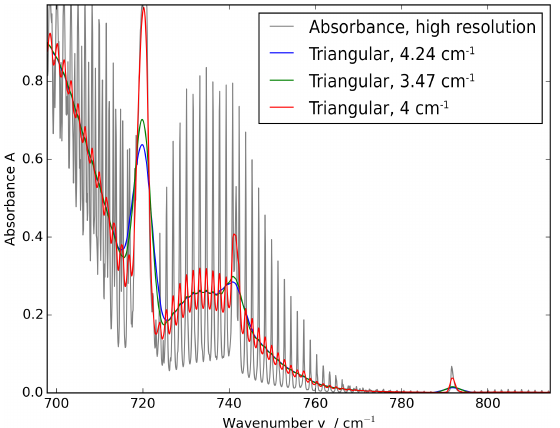
Figure 12. Example of simulated CO 2 absorbance spectra (line con- centration 40000ppmm, T = 298K, p = 1atm) for wavenumber region 700–800cm − 1 . The relative absorbance error (cid:49)A/A for a known uncertainty in wavenumber resolution accuracy given by the manufacturer’s specifications is in the range between 2 and 6.5%. Besides the wavenumber accuracy, the applied apodization function (here triangular) also affects the relative absorbance error.